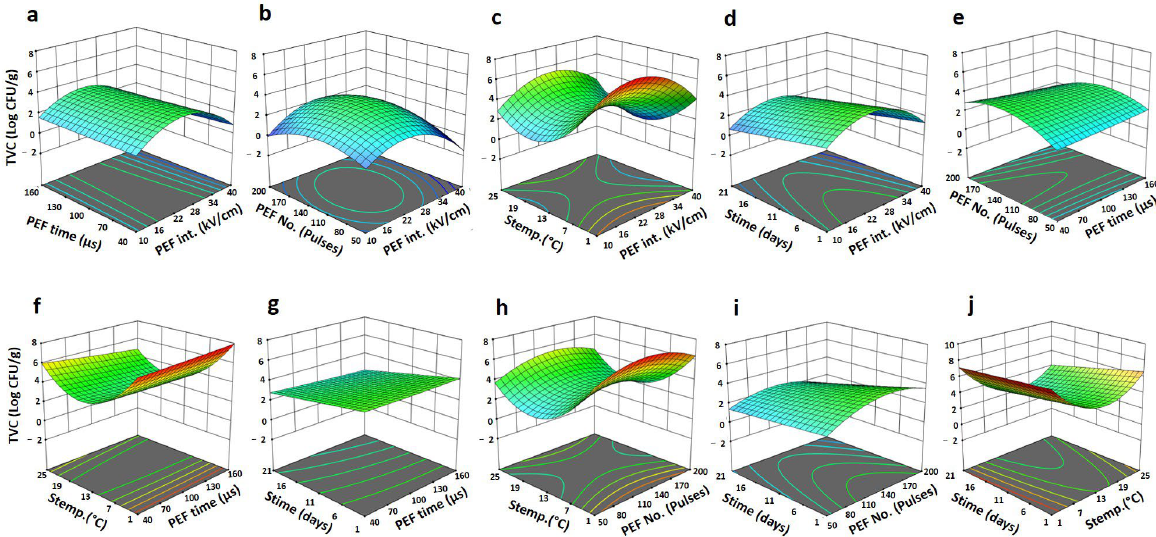
Figure 5. Response surface plots of total viable count (TVC) of Barhi dates as a function of PEF time and PEF intensity ( a ), PEF number of pluses and PEF intensity ( b ), storage temperature and PEF intensity ( c ), storage time and PEF intensity ( d ), PEF number of pulses and PEF time ( e ), storage temperature and PEF time ( f ), storage time and PEF time ( g ), storage temperature and PEF number of pulses ( h ), storage time and PEF number of pulses ( i ), and storage time and storage temperature ( j